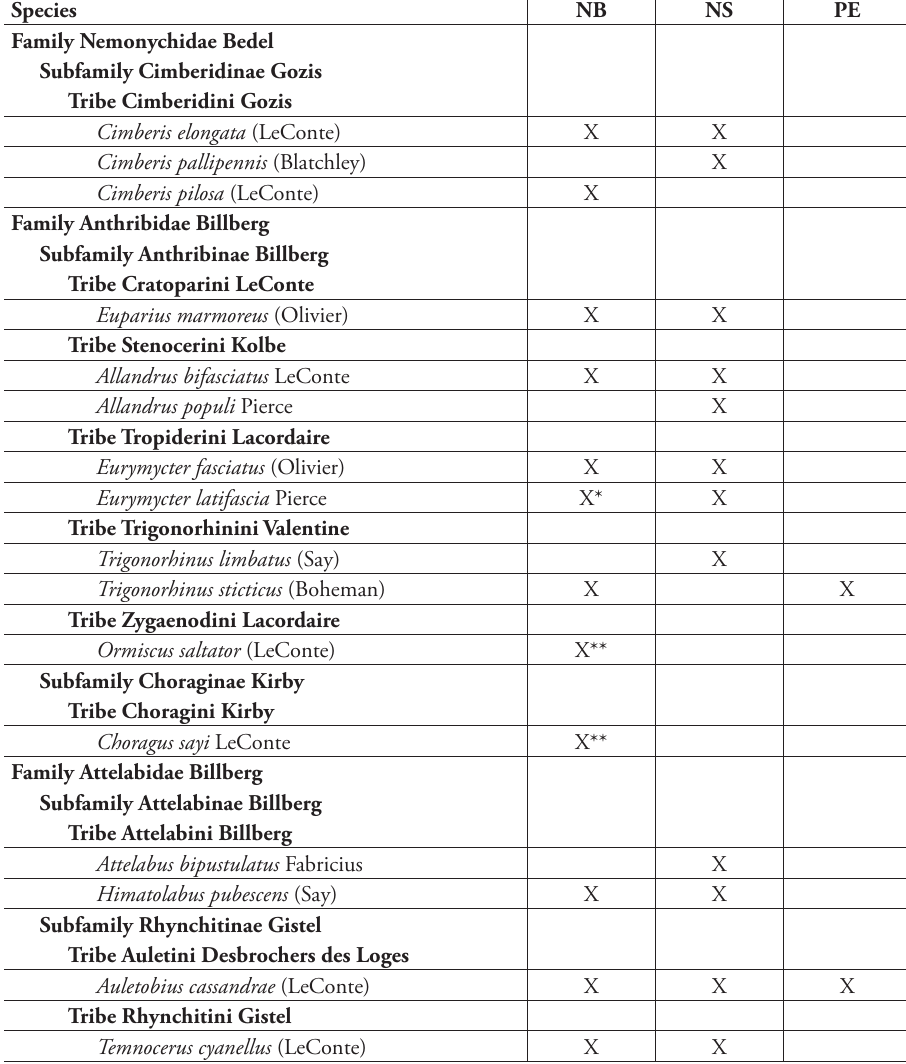
table 1. Species of Nemonychidae, Anthribidae, Attelabidae, Brentidae, Dryophthoridae, Brachyceri- dae, and Curculionidae (Curculionoidea) recorded from New Brunswick, Prince Edward Island, and Nova Scotia,